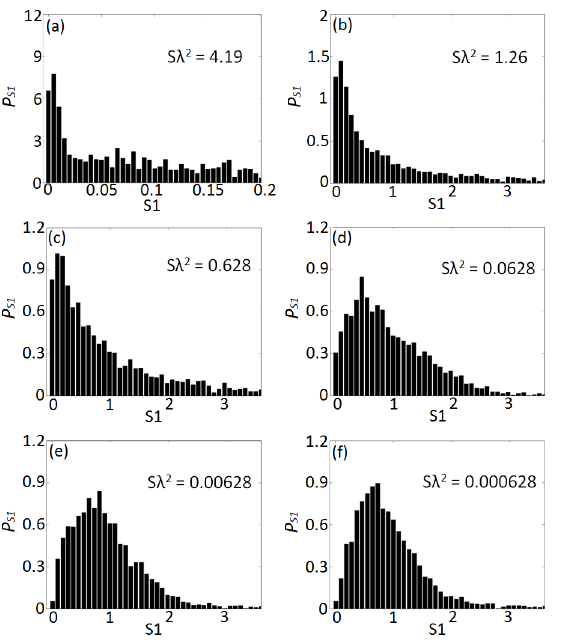
Figure 13. Level statistics of first-neighbor eigenvalues in the complex plane for an N = 1108 Penrose array with S λ 2 values as indicated in the panels. The value of first level spacing, S 1 , is computed at the nearest neighbor distance between eigenvalues in the complex plane for each eigenvalue, and is normalized by the average S 1 for each case. The probability density is normalized such that the total probability equals to